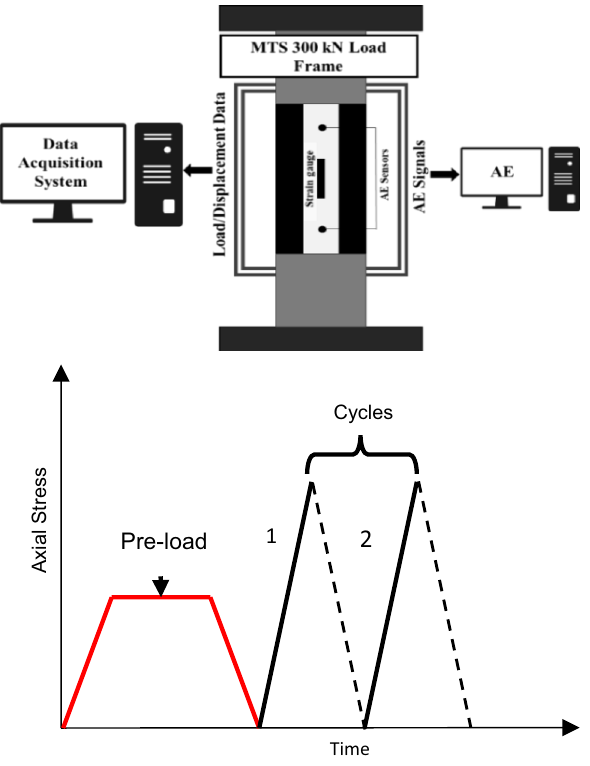
Fig. 8 Schematic of the experimental setup and the loading